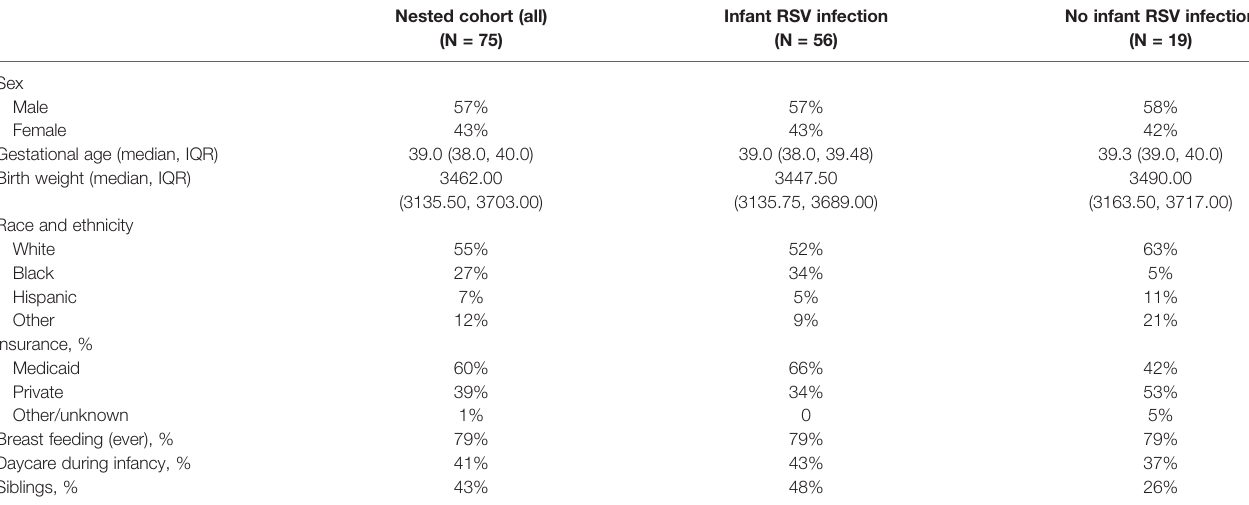
TABLE 1 | Demographic characteristics of children in nested